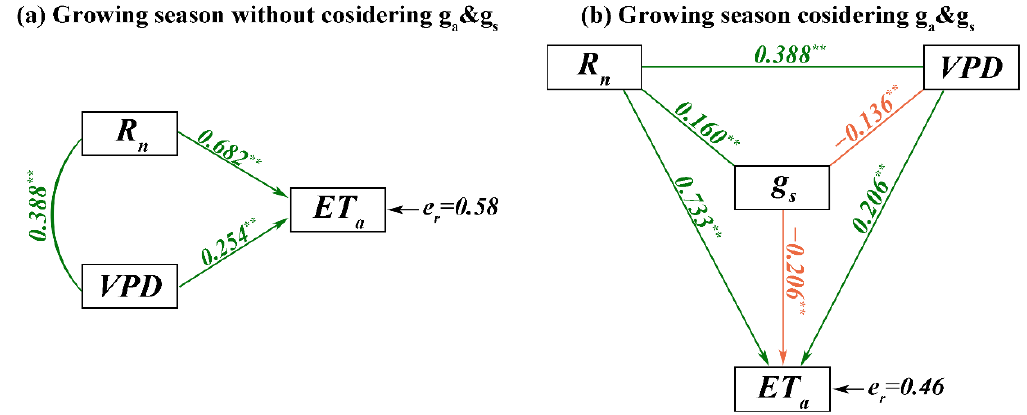
Figure 9. ( a ) The structure of MF G and MF NG given by path analysis without considering g a and g s during the growing season; and ( b ) that while considering g a and g s during the growing season. One-way influence was denoted by arrows; the interplay of environmental elements was represented by a line without arrows. Additionally, green and orange colors implied positive and negative relationships between the actual evapotranspiration (ET a ) and environmental element. e r indicates that the residual error was calculated by e r = (1 − R 2 ) 1/2 . The asterisk superscript implies that the value passed the 95% significance t -test.